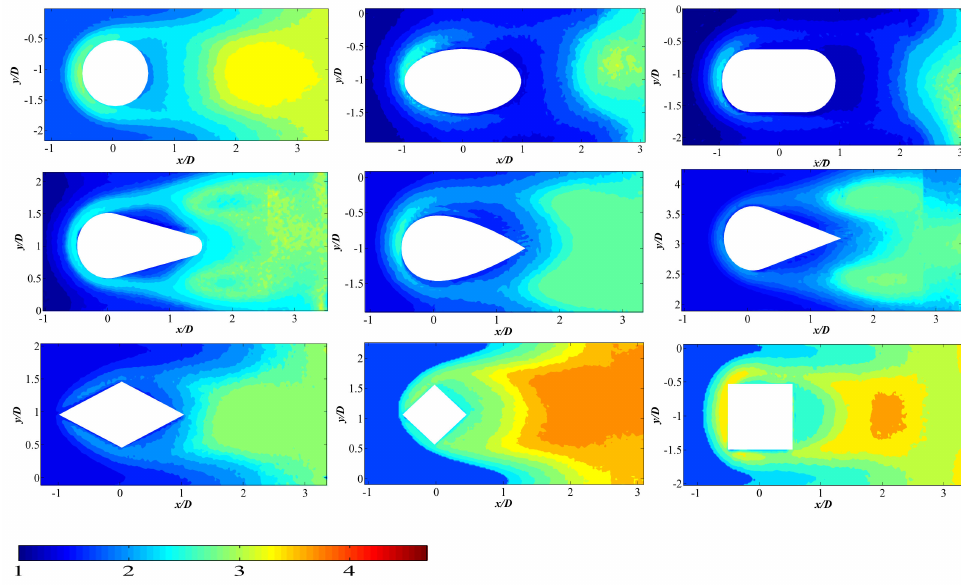
Figure 7. Nu / Nu 0 distribution comparison, Row1, Re =